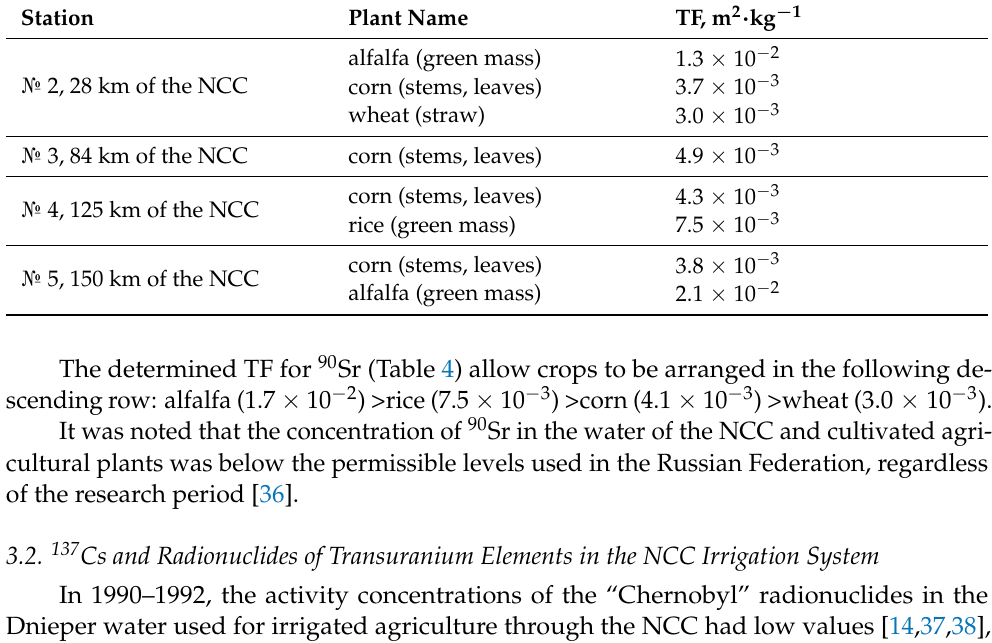
Table 4. Transfer factors (TF) of 90 Sr from irrigated soils to agricultural plants.